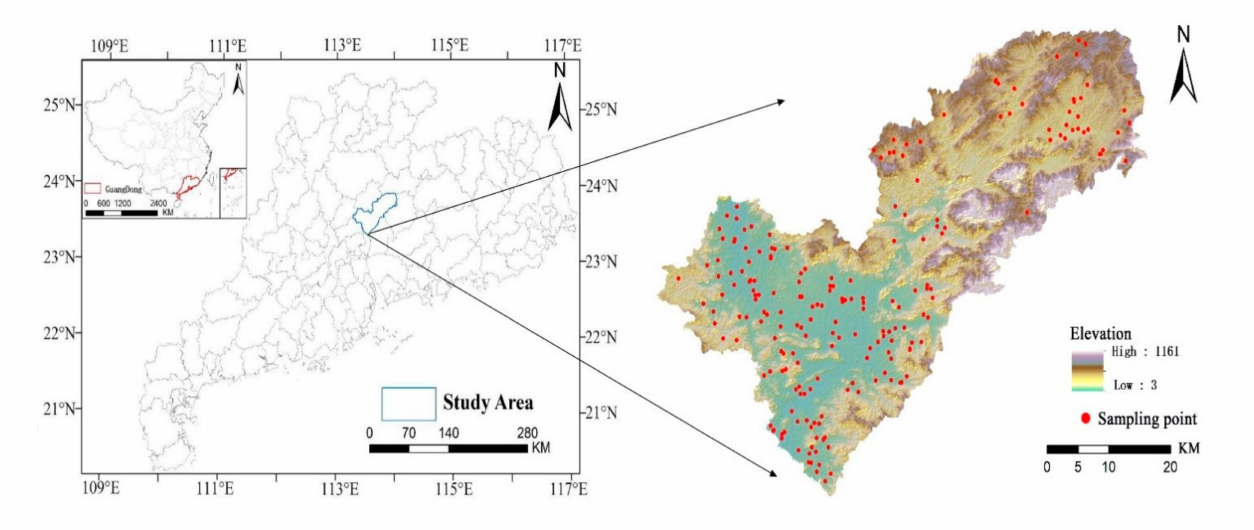
Figure 1. Location of the study area and sampling point